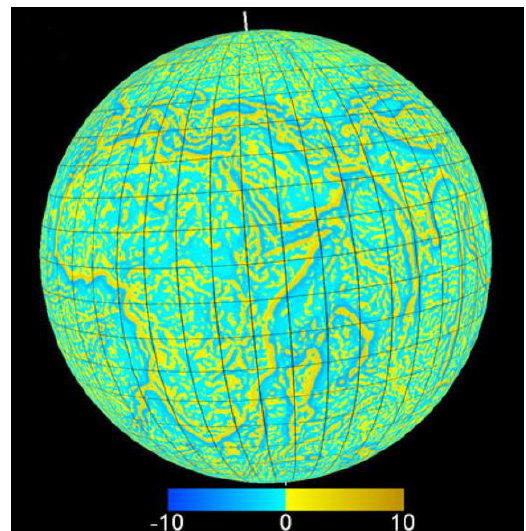
Figure 2. One of the Earth morphometric parameters (vertical curvature) derived from SRTM30_PLUS (Becker et al., 2009) to produce a virtual